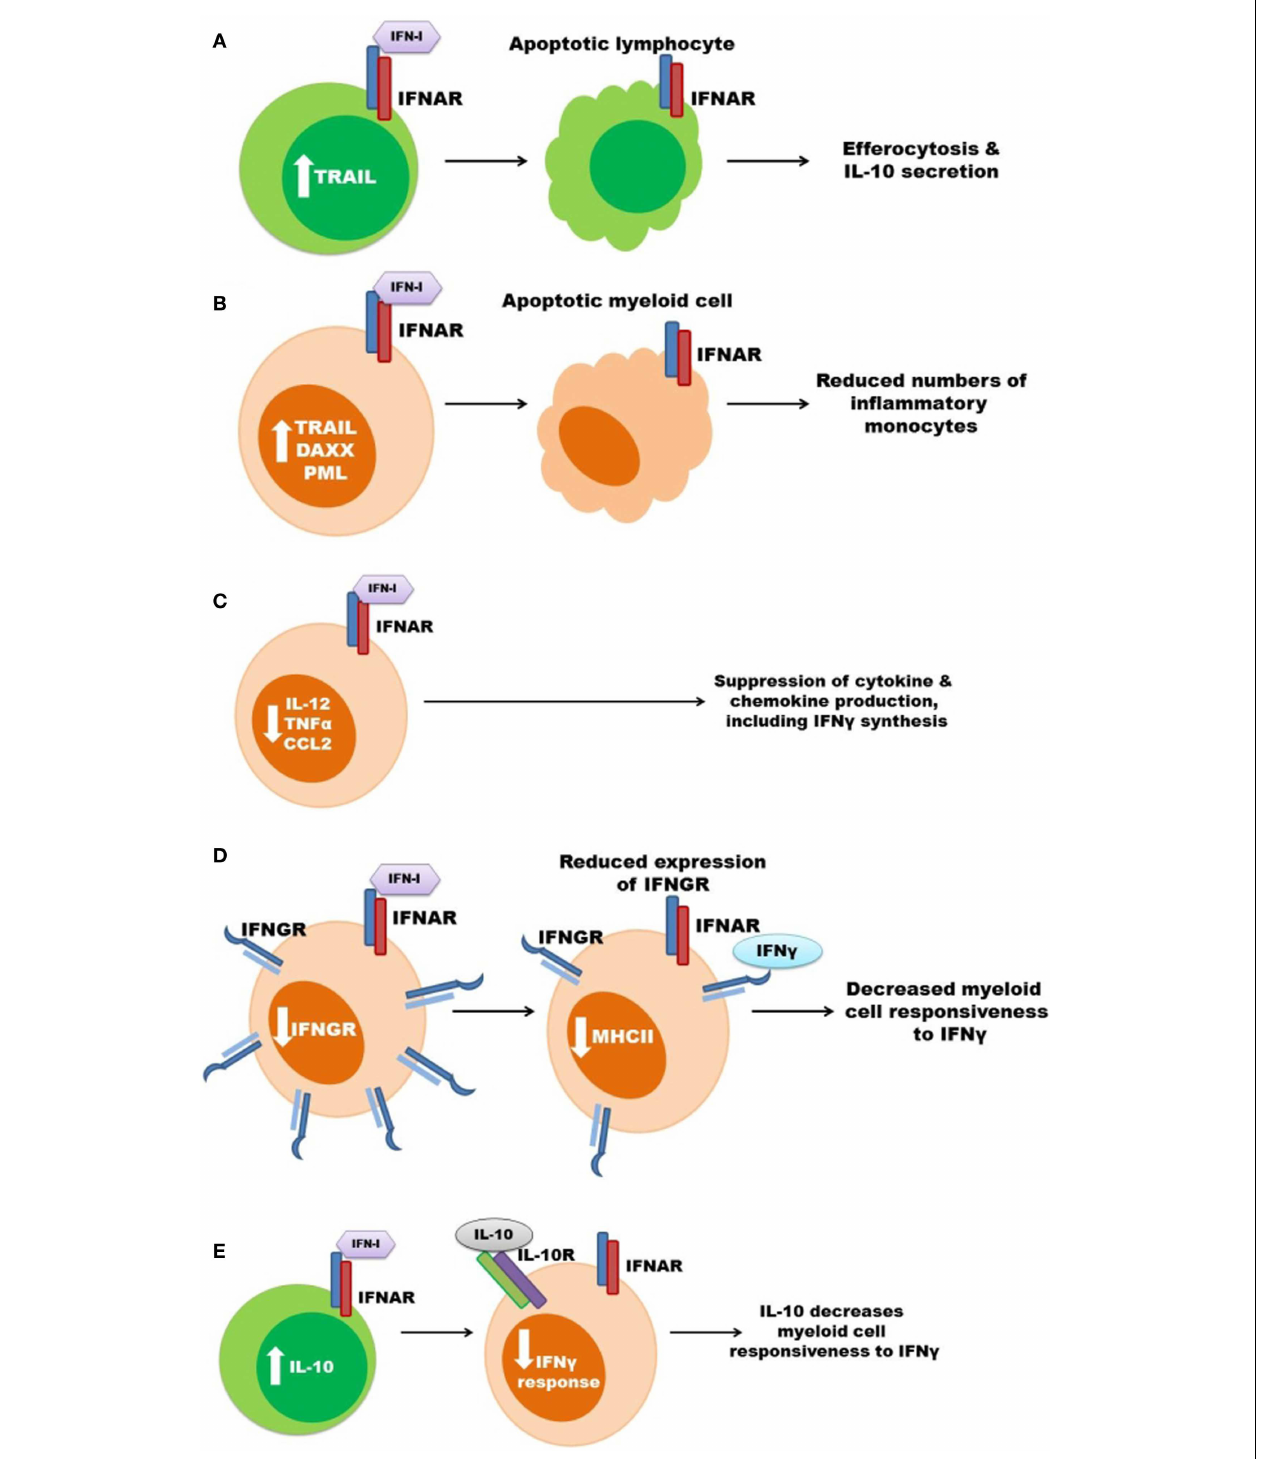
infection. (C) Signaling through the IFNAR suppresses myeloid cell secretion of pro-inflammatory cytokines and chemokines, which can result in decreased IFN γ production. (D) Expression of IFNGR is suppressed in response to type I IFN signaling in myeloid cells thus decreasing cellular responsiveness to IFN γ . (E) Type I IFNs induce the production of IL-10 to inhibit IFN γ